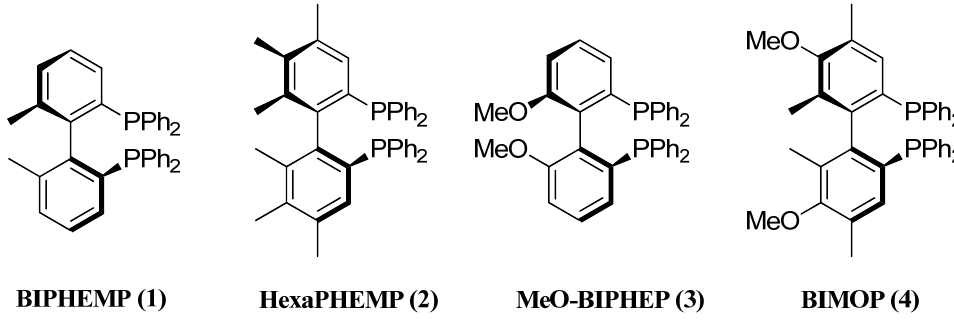
Figure 1. Atropisomeric biaryl bisphosphines.